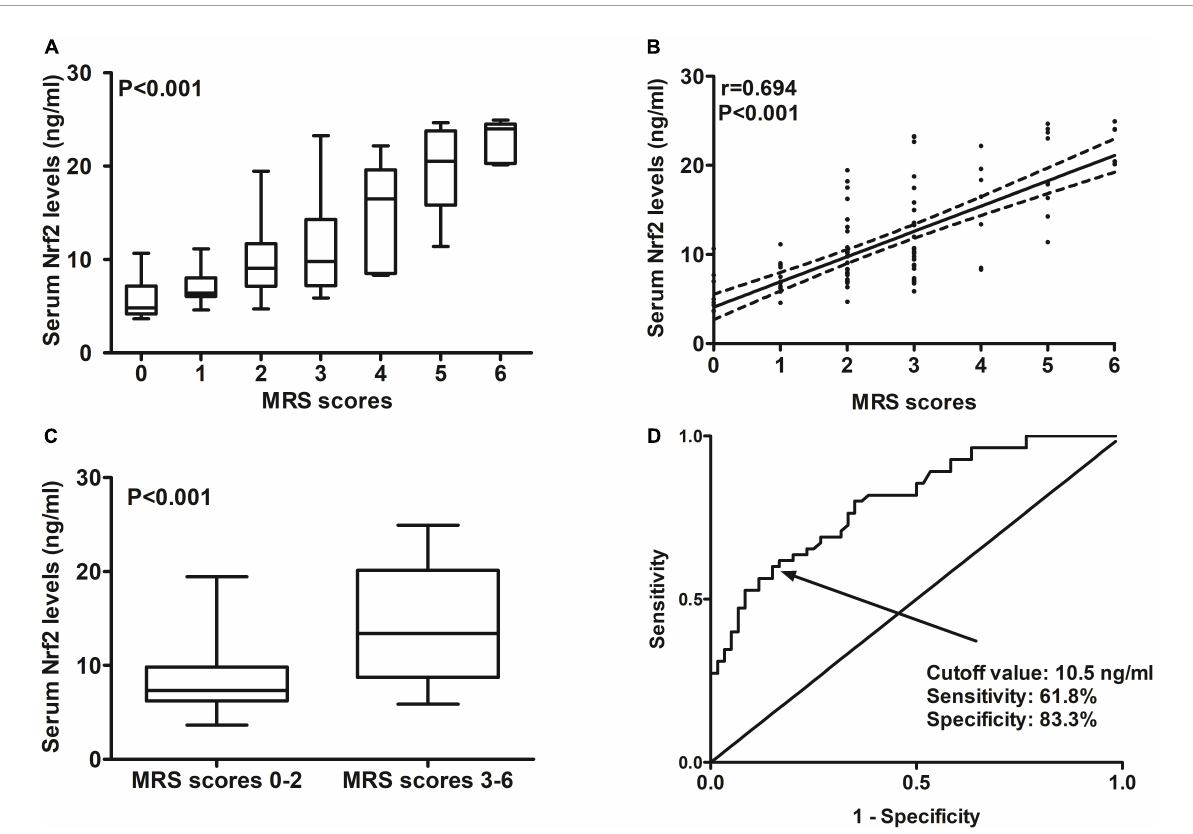
FIGURE6 Predictive ability with respect to serum nuclear factor erythroid 2-related factor 2 (Nrf2) levels for post-stroke 90-day poor prognosis after acute supratentorial intracerebral hemorrhage (ICH). (A) Comparisons of serum Nrf2 levels among subgroups based on modified Rankin scale (mRS) scores. (B) Relationship between serum Nrf2 levels and mRS scores. (C) Comparison of serum Nrf2 levels between patients with mRS scores 3–6 and those with scores 0–2. (D) Discriminatory capability of serum Nrf2 levels for post-stroke 90-day poor prognosis under the receiver operating characteristic (ROC) curve. Serum Nrf2 levels were intimately correlated with mRS scores and were markedly higher in patients with mRS scores 3–6 than in those with scores 0–2 (all P < 0.001). Serum Nrf2 levels statistically significantly predicted 90-day poor prognosis after acute stroke ( P < 0.001). Nrf2 indicates nuclear factor erythroid 2-related factor 2; mRS, modified Rankin scale.